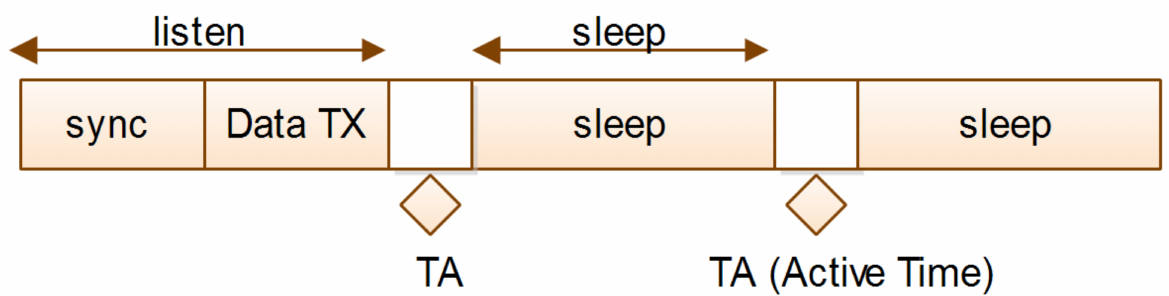
Figure 6. The sleep‑wake up schedule of T‑MAC protocol.